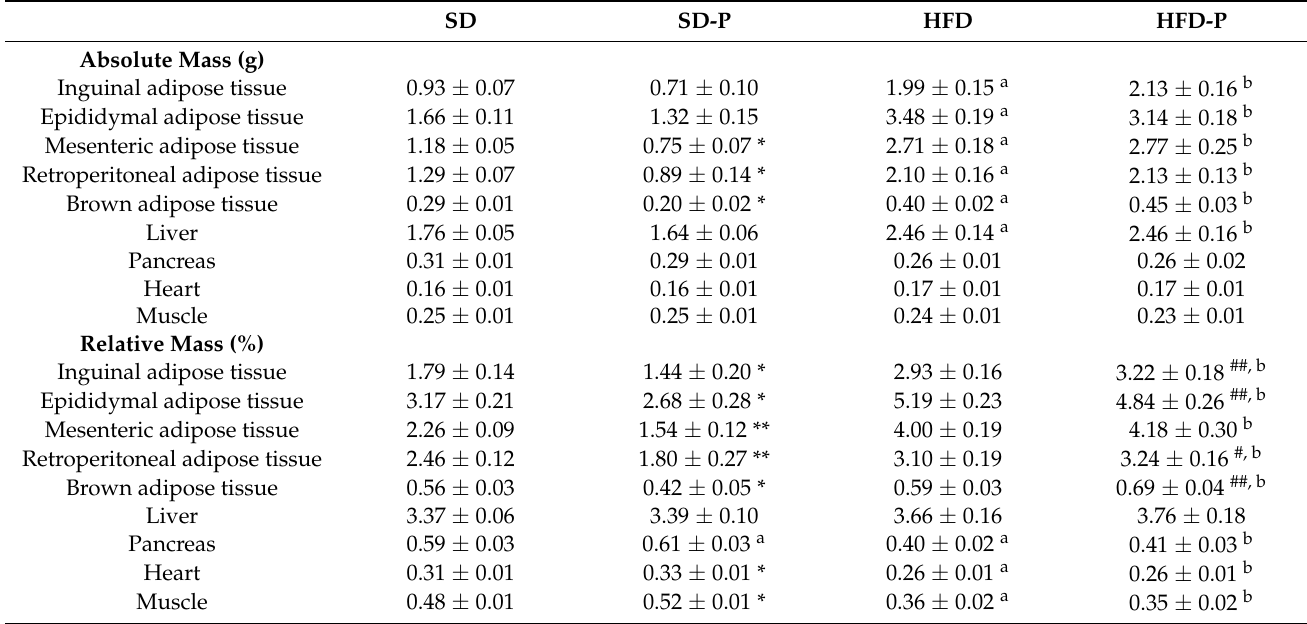
Table 2. Tissue weights from experimental